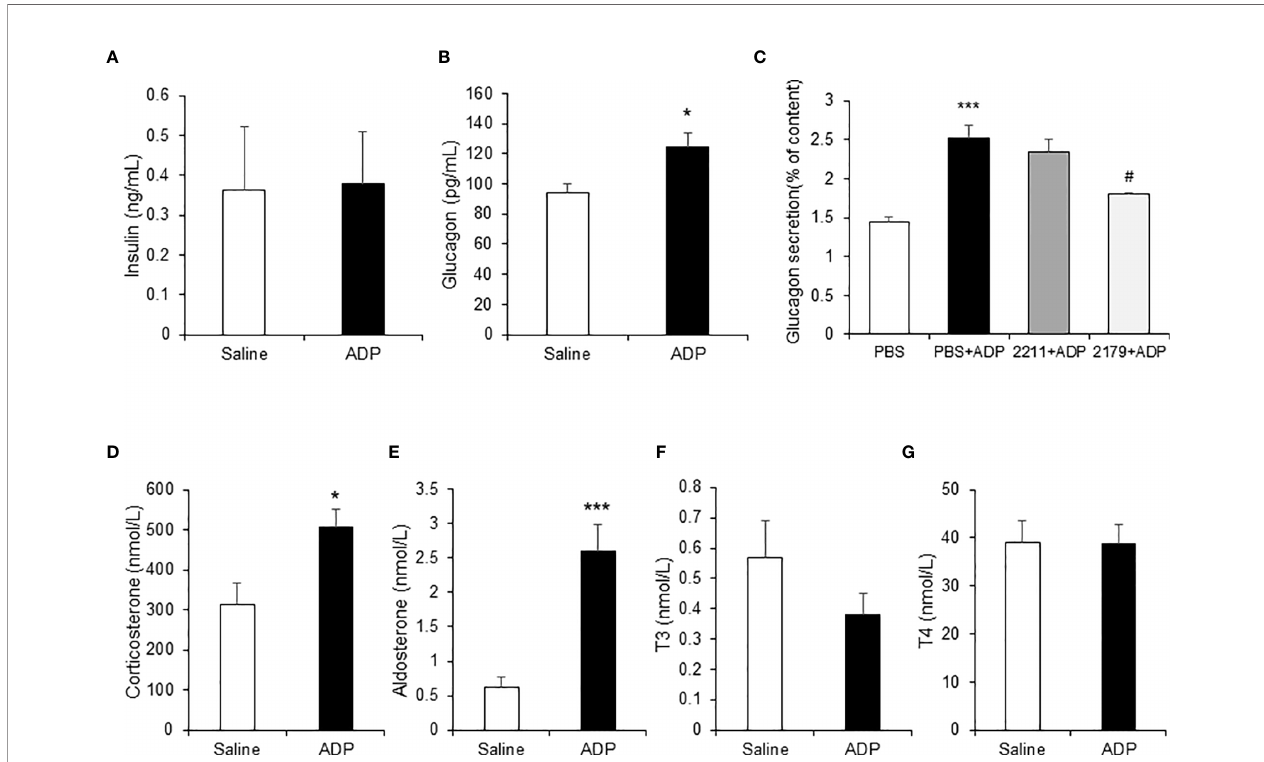
FIGURE 5 | ADP induced glucogenic hormones. The hormones of insulin, glucagon, corticosterone, aldosterone and thyroid hormones were examined in the mouse plasma after ADP injection at 1h. The levels of insulin and glucagon in plasma were detected with ELISA (n=4). (A) Insulin; (B) Glucagon. (C) ADP induction of glucagon secretion. a TC1-6 cells were treated with 2.5 mM ADP and pretreated with MRS2211 (50 m M) or MRS2179 (50 m M) for 0.5h in the study. The cellular experiments were repeated at least three times with consistent results. The hormones were determined in the plasma after ADP injection for 1h (n=6). (D) Corticosterone; (E) Aldosterone; (F) T3; (G) T4. The data in the bar fi gure represents mean ± SEM. *p < 0.05; ***p < 0.001 vs. the control group in (B, D, E) . ***p < 0.001 vs. the PBS group; # p < 0.05 vs. the PBS+ADP group in the panel (C)